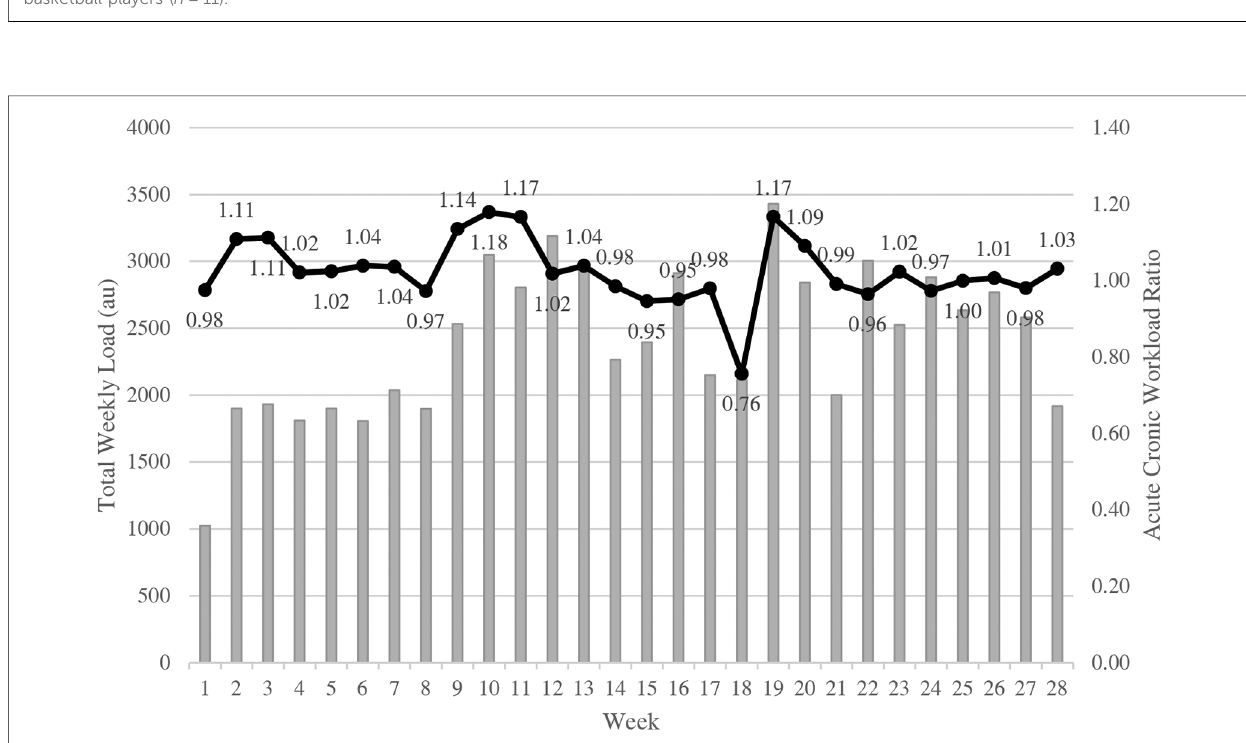
FIGURE 2 Weekly totals presented in arbitrary units (AU) combined with line graphs that represent acute to chronic workload ratios (ACWR) in collegiate female basketball players ( n